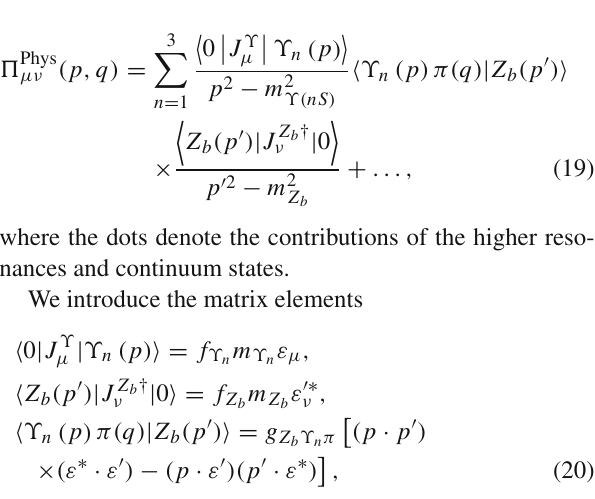
Fig. 2 The dependence of the current coupling f Z at fixed M 2 (right panel)